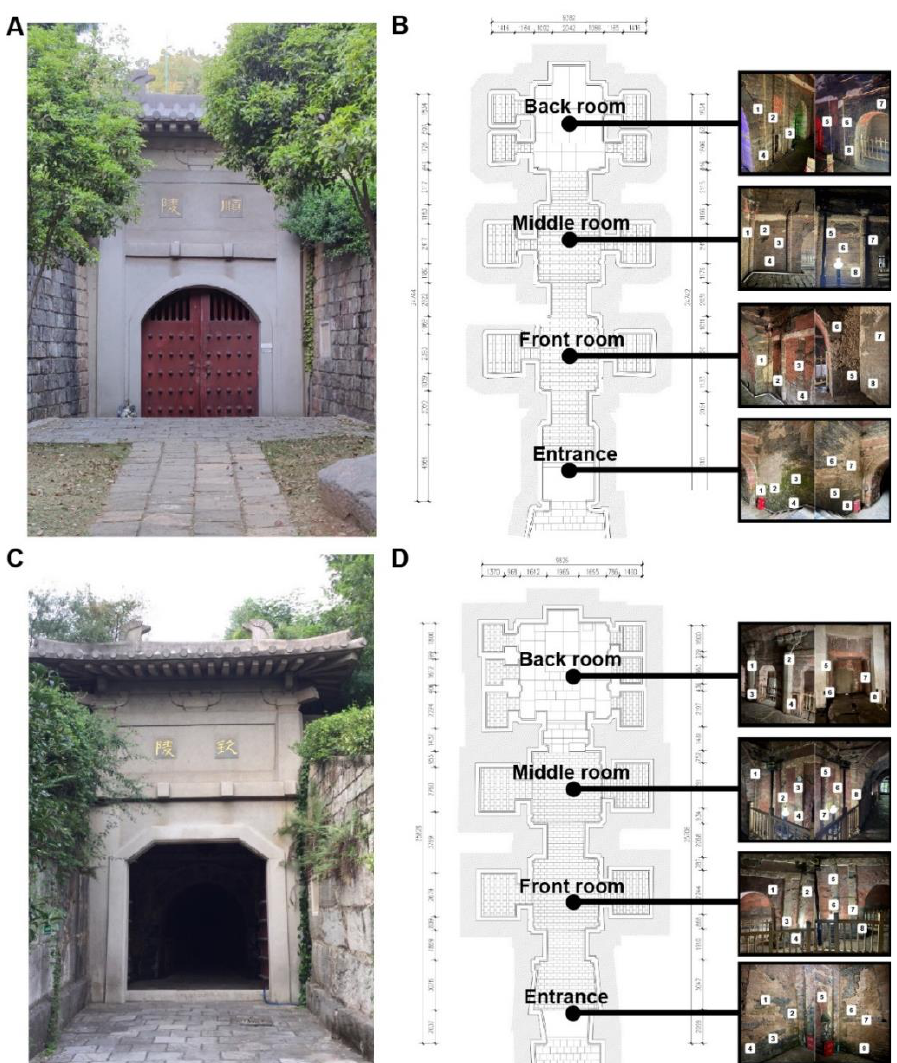
Figure 1. Shunling Mausoleum ( A ) and Qinling Mausoleum ( C ) have a 1000 years history and have been accessible for over 70 years. The sampling positions in the Shunling Mausoleum ( B ) and Qinling Mausoleum ( D ). The numbers in the figure ( B , D ) represented sampling sites in different rooms.